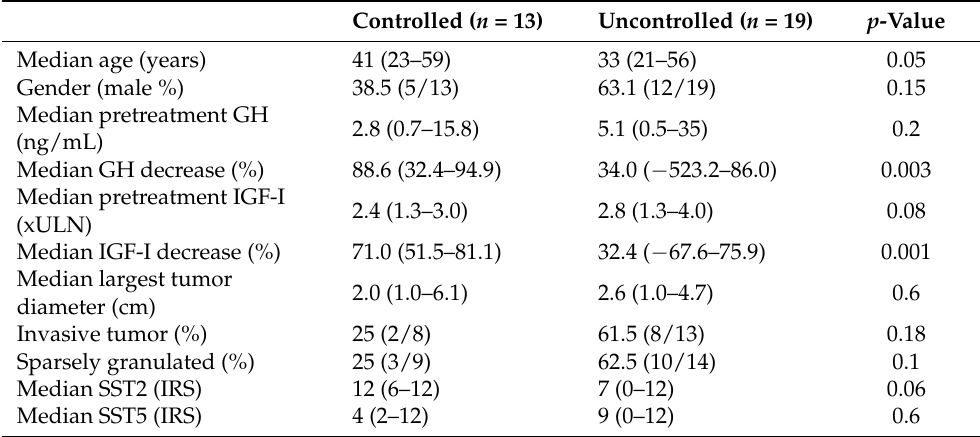
Table 1. Characterization of controlled and uncontrolled